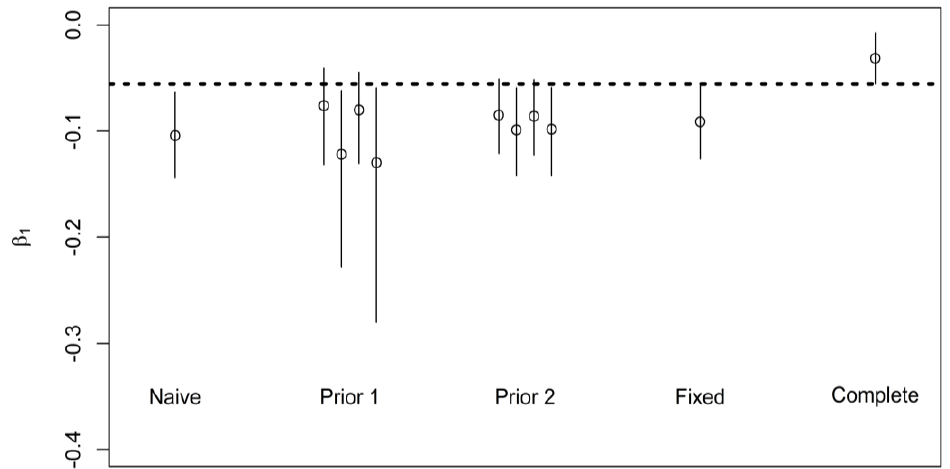
Figure 6. Estimated change in log(FVC, ml) among 570 male current smokers in NHANES 2011–2012 under different priors; naïve analysis is the association with log(years of smoking), complete analysis is the association with log(pack-years), see text for description of different priors (Prior 1, Prior 2, Fixed) that use information on correlation of logarithms of duration and pack- years (ρ) and ratio of standard deviations of logarithms of packs/day and duration (k); circles represent 50 th percentile of posterior distributions and line span the 95% credible intervals, dashed line represents lower bound of the 95% credible interval with complete data.